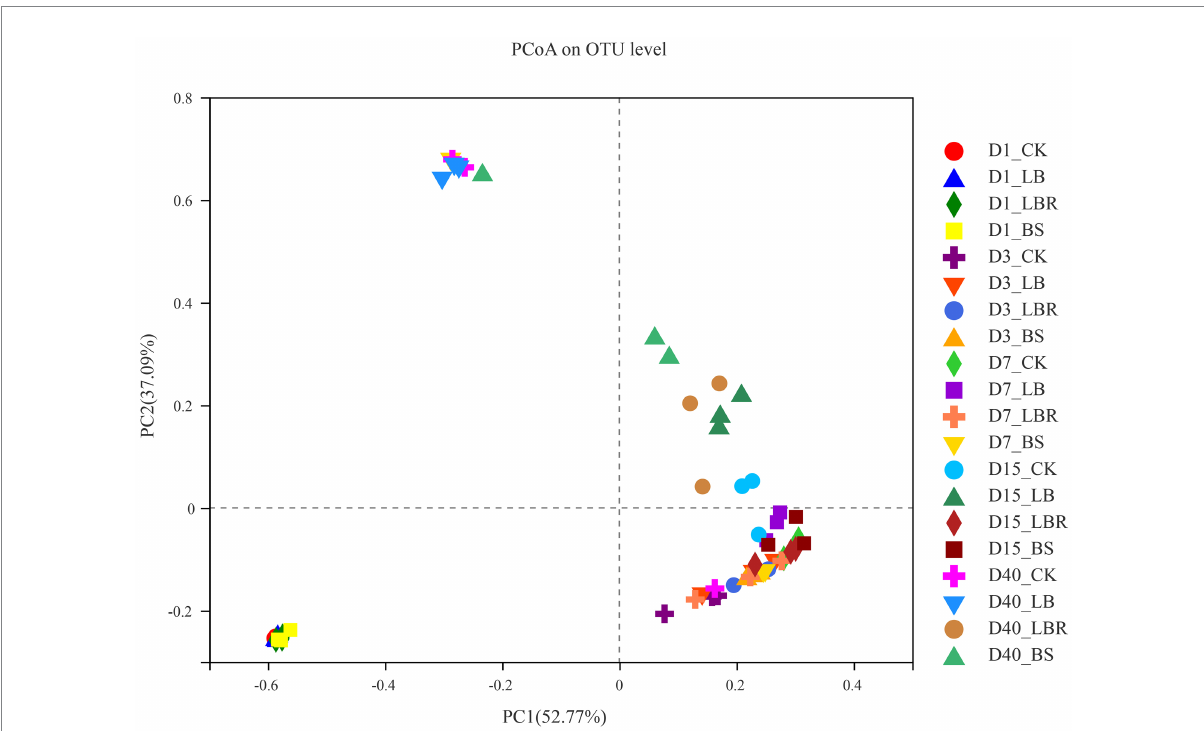
FIGURE 1 Principal component analysis (PCoA) of bacterial communities in sorghum-sudangrass silage after ensiling for 1, 3, 7, 15, and 40 days (CK, control; LB, Lactobacillus buchneri ; LBR, Lactobacillus brevis; BS, Bacillus subtilis ).